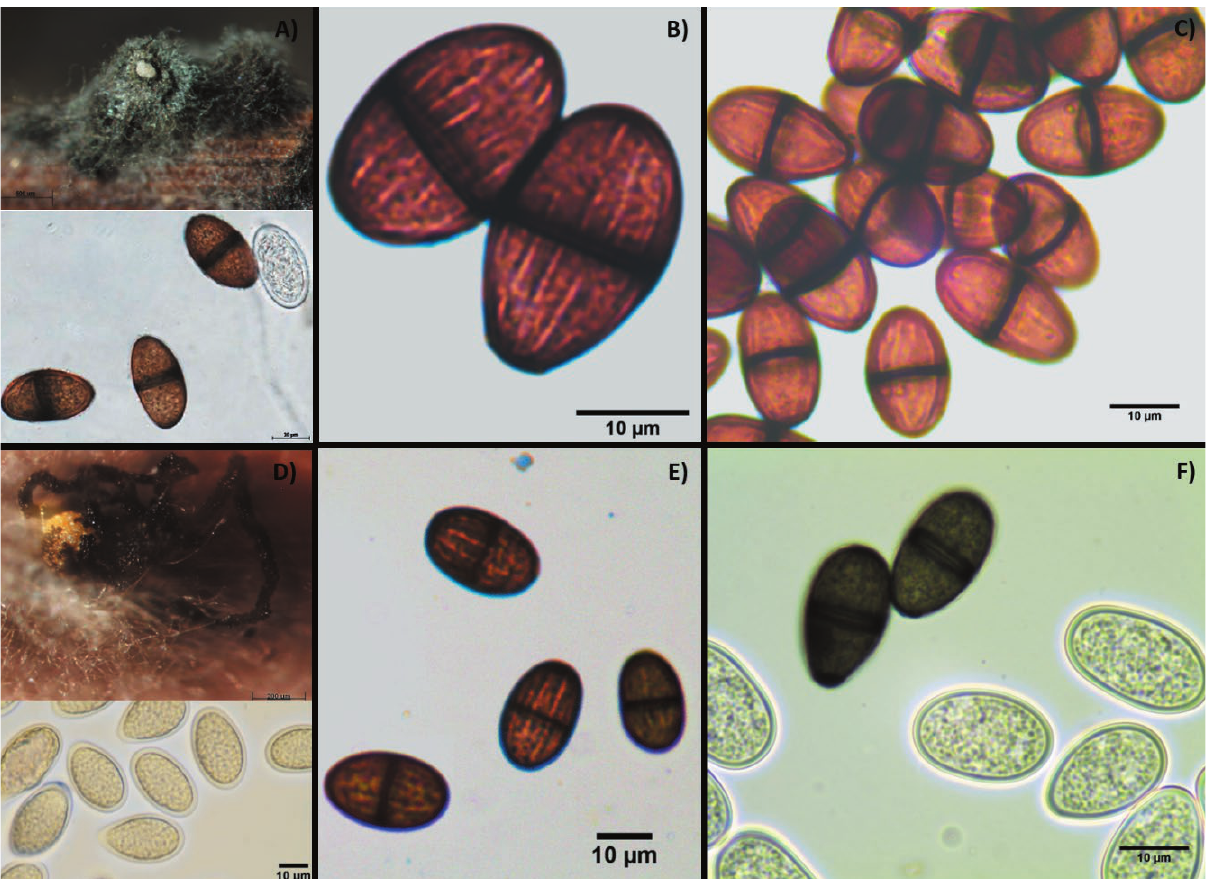
Figure 3. Conidia of Lasiodiplodia spp. isolates. A) L. brasiliensis MXBCL28, B) L. brasiliensis MXVS18, C) L. exigua MXVS21b, D) L. gilan- ensis MXBCCS01, E) L. crassispora MXVS1b, F) L. exigua